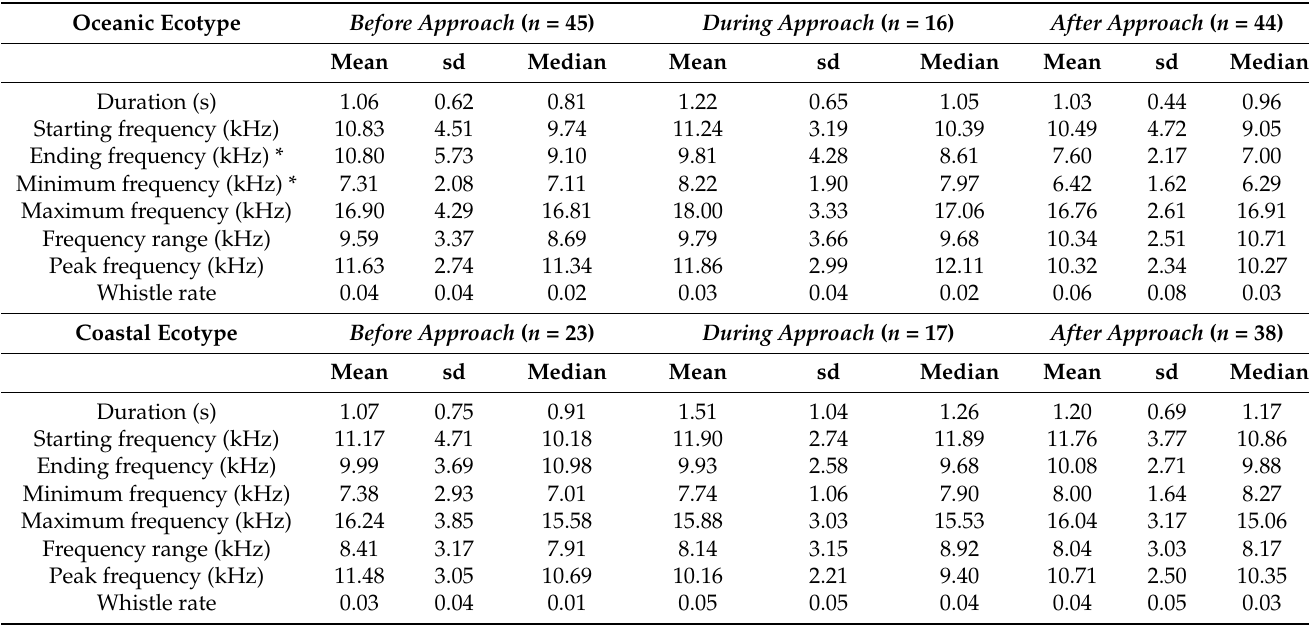
Table 4. Descriptive statistics of the whistle parameters and rates of the two bottlenose dolphin ecotypes before approach, during approach and after approach of a single small vessel.